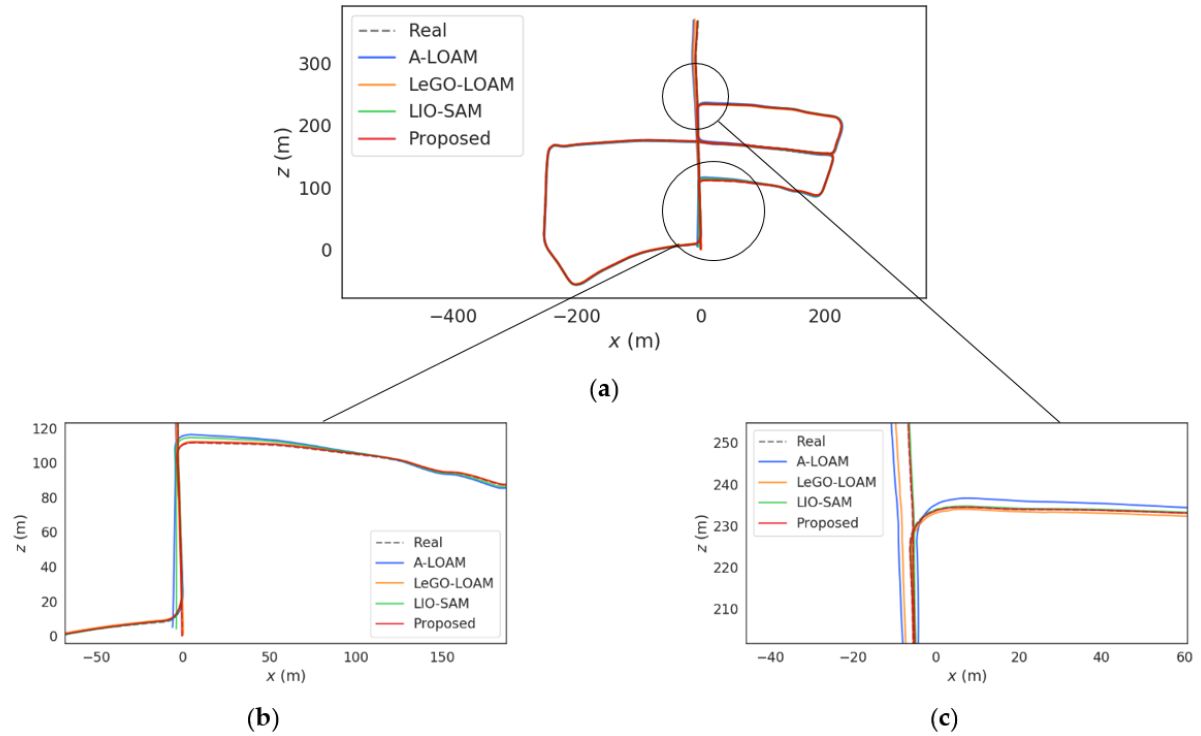
Figure 10. Comparison of the estimated trajectories. ( a ) Global positioning trajectory. ( b ) Local details of the trajectory. ( c ) Local details of the trajectory. Table 4. Comparison of ATE_RMSE(m) of each algorithm in KITTI_RAW